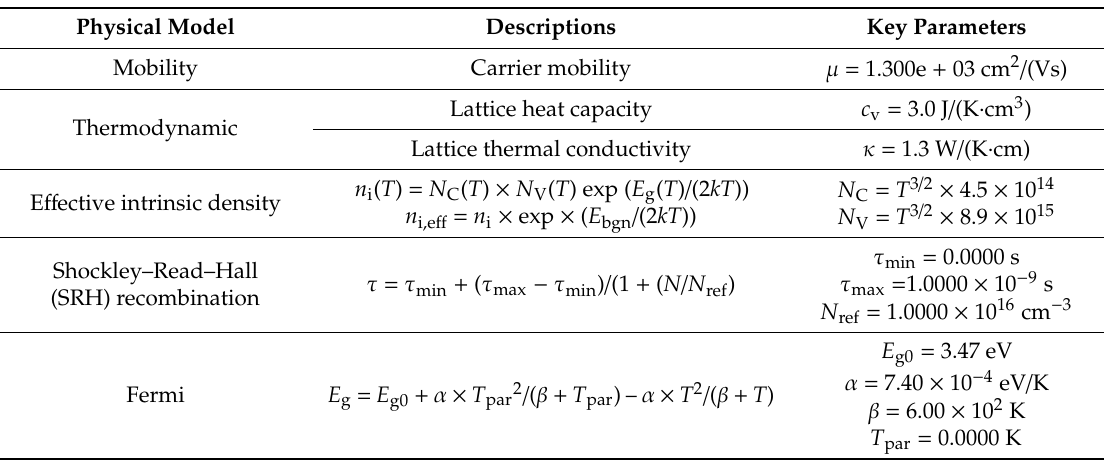
Table 1. Key parameters used in